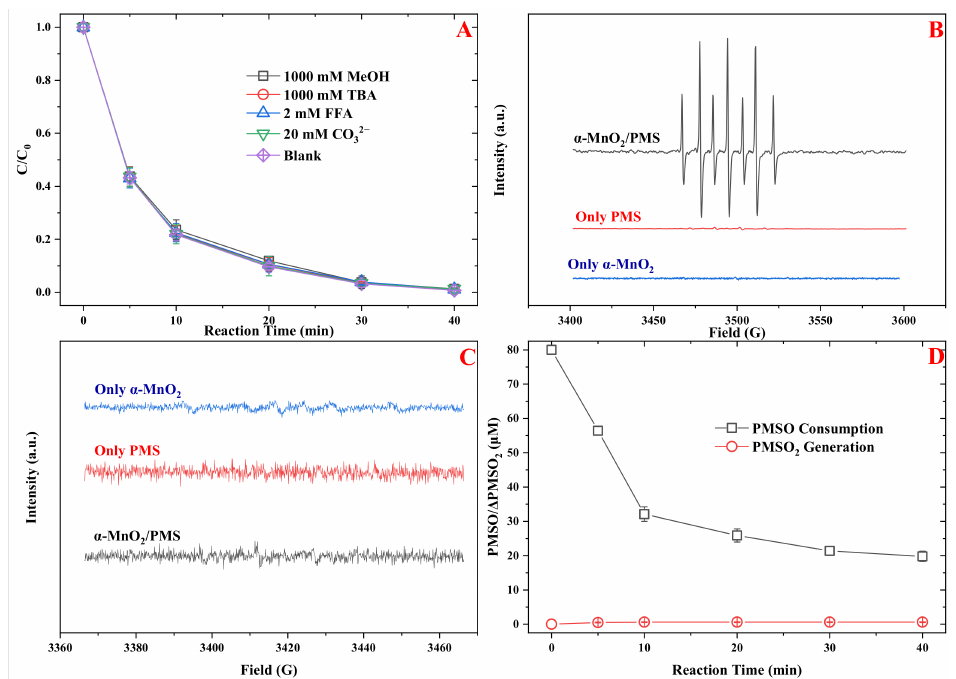
Figure 2. Effects of various ROS quencher on phenol removal ( A ), EPR spectra in the presence of DMPO ( B ), EPR spectra in the presence of TEMP ( C ) and PMSO consumption and PMSO 2 generation in α -MnO 2 /PMS system ( D ). Reaction conditions: [ α -MnO 2 ] 0 = 0.2 g/L, [PMS] 0 = 1.5 mM, [phenol] 0 = 20 mg/L, pH 0 = 7.0, Temperature = 30 ◦